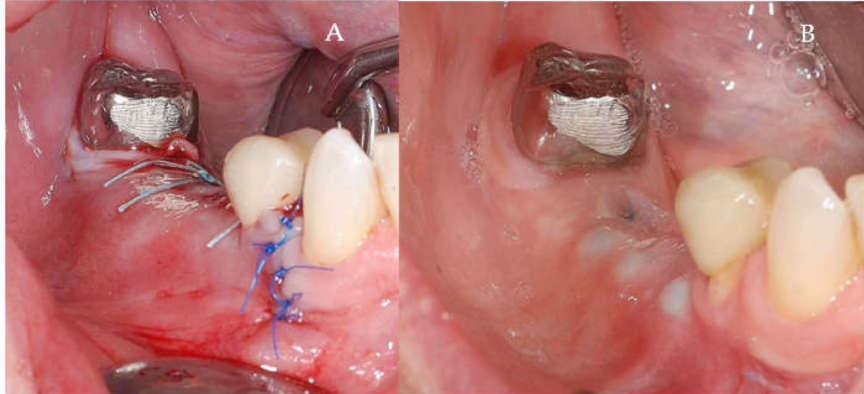
Figure 5. ( A , B ) Follow-up of the S-GBR surgery. ( A ) Tension-free sutures. ( B ) Clinical aspect at 7 months